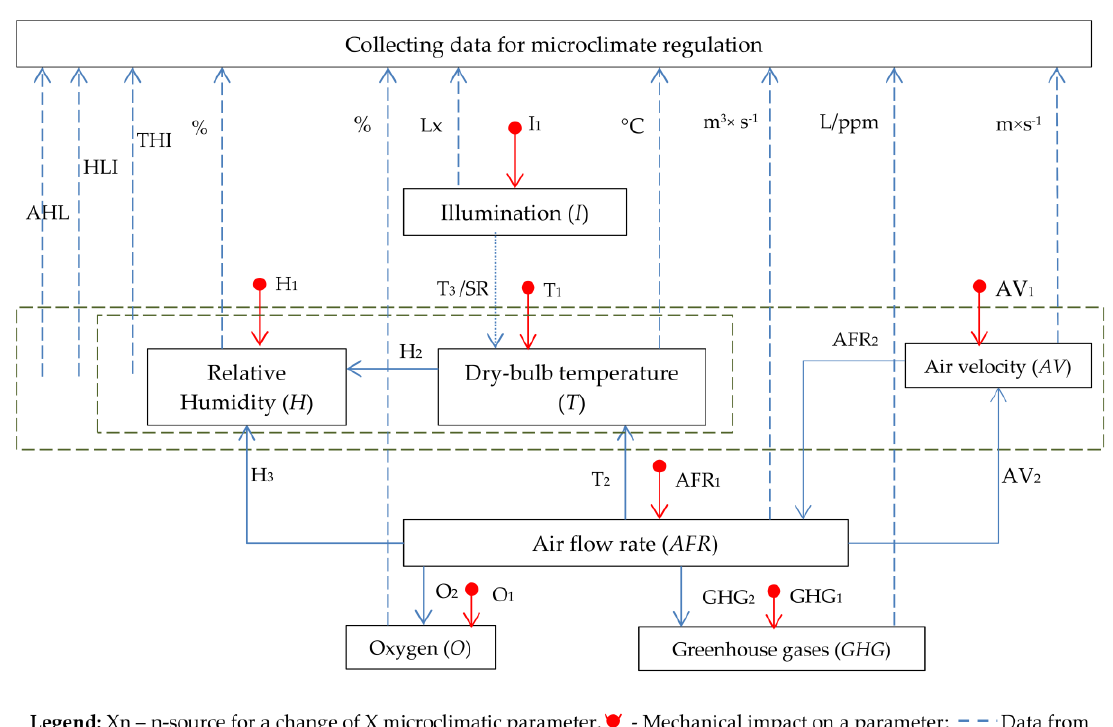
Figure 1. Interrelation between microclimatic parameters and